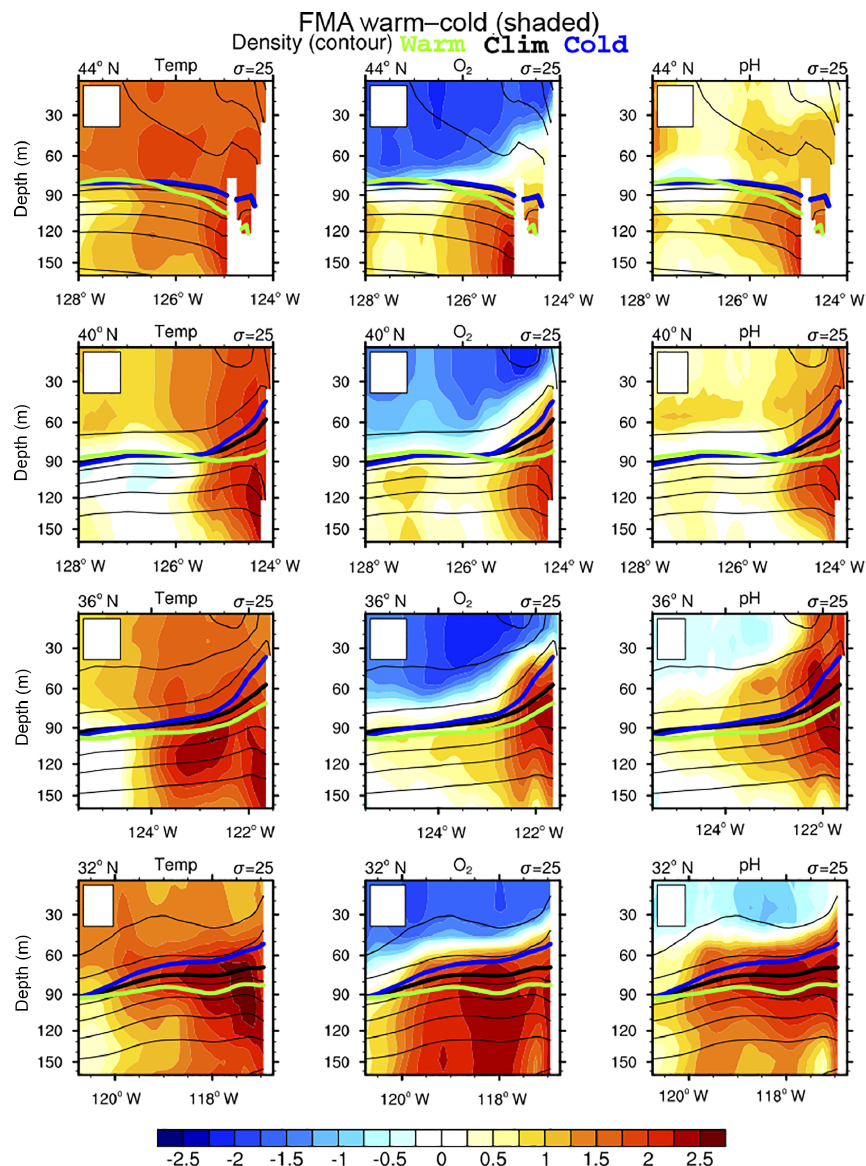
Figure 7. ESM2.6 depth–longitude cross sections of FMA warm–cold high-pass-filtered standardized anomalies (unitless) of (first column) temperature, (second column) O 2 , and (third column) pH (shaded) with mean climatological density lines (contour) along (first row) 44 ◦ N, (second row) 40 ◦ N, (third row) 36 ◦ N, and (fourth row) 32 ◦ N for the 222km nearest the US west coast. The bold lines show the positions for the σ = 25 level for the climatology (black), El Niño conditions (green), and La Niña conditions (blue), and the thin lines indicate density increments of